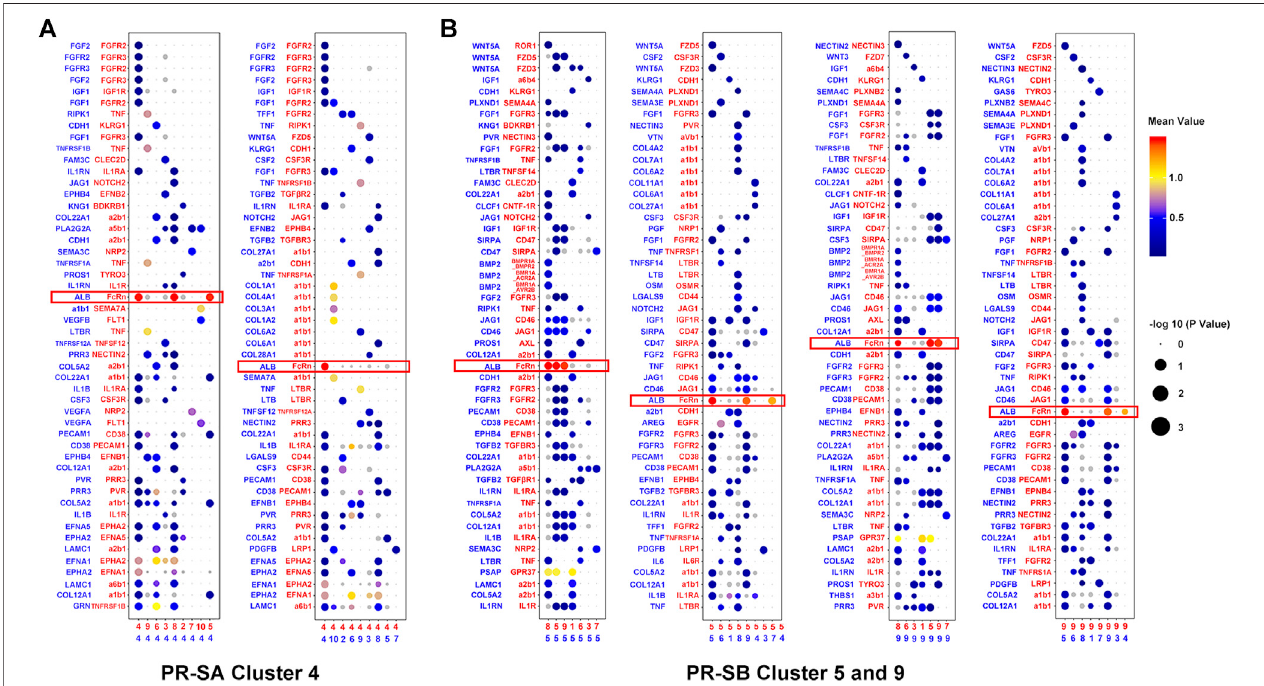
FIGURE 4 | Cell-cell communication network between PR cell clusters and other cell clusters. (A) Bubble plots showed the interaction strength of ligand-receptor pairs of cluster four in the PR-SA group. (B) Bubble plots showed the interaction strength of ligand-receptor pairs of cluster fi ve and nine in the PR-SB group. Red represented receptors and blue represented ligands. The color and area of the dots represent the intensity of the interaction.